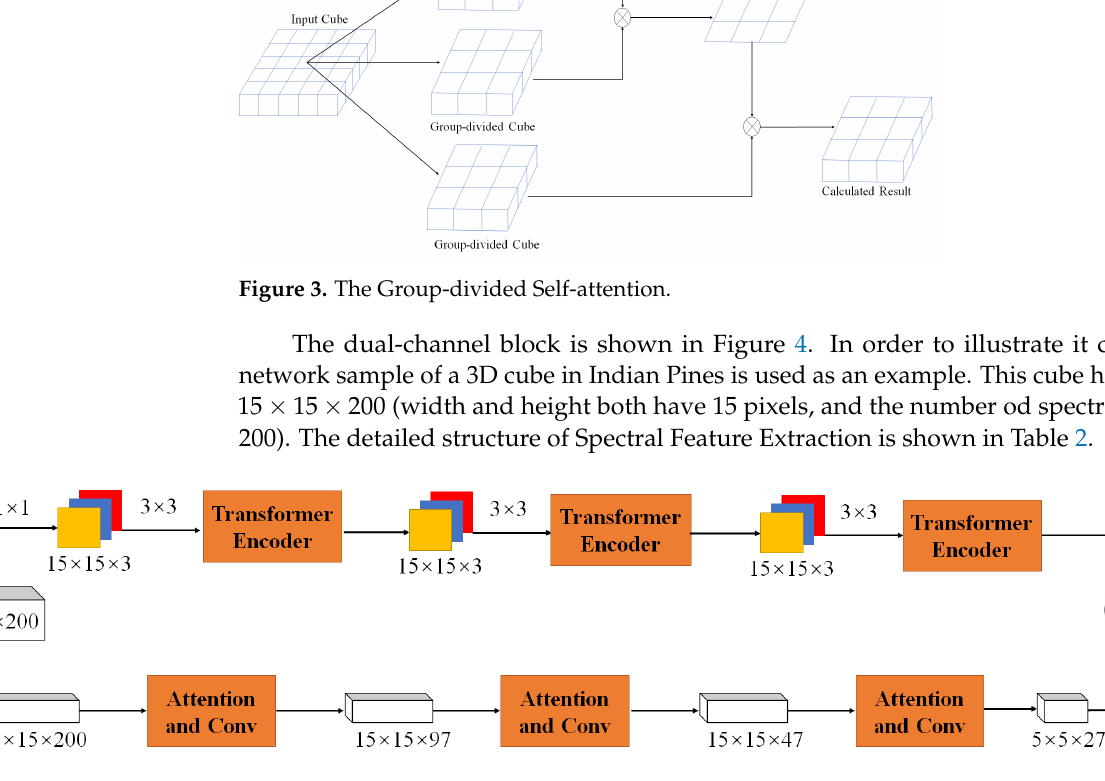
Figure 4. The dual-channel module that extracts spatial features and spectral features. Table 2. The detailed structure of Spectral Feature